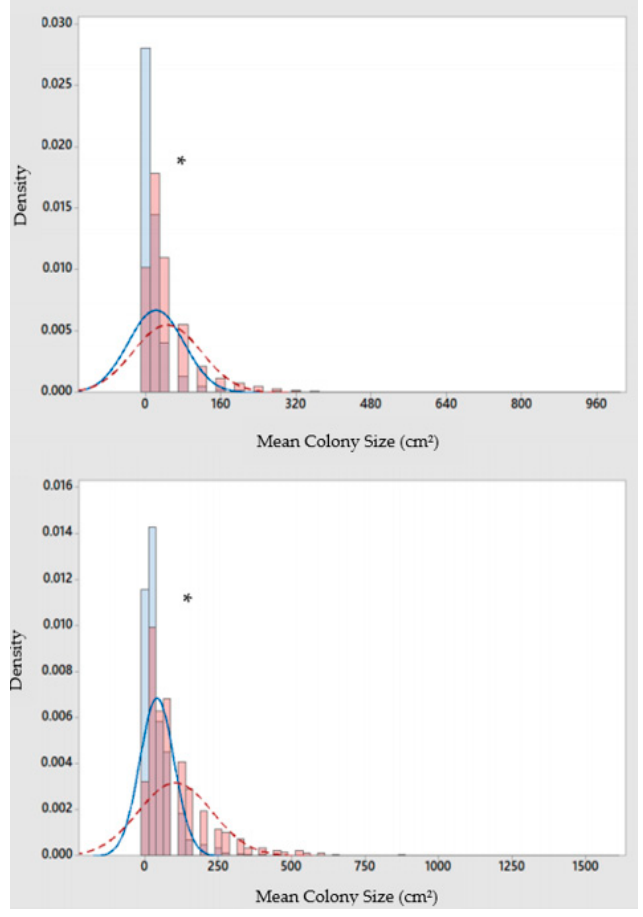
Figure 6. Size-frequency distribution of P. astreoides colonies in Carriacou (top) and Grenada (bottom) in 2014 (dark grey bar; solid line) and 2017 (light grey bar; dashed line). * Indicates significance at p < 0.05.